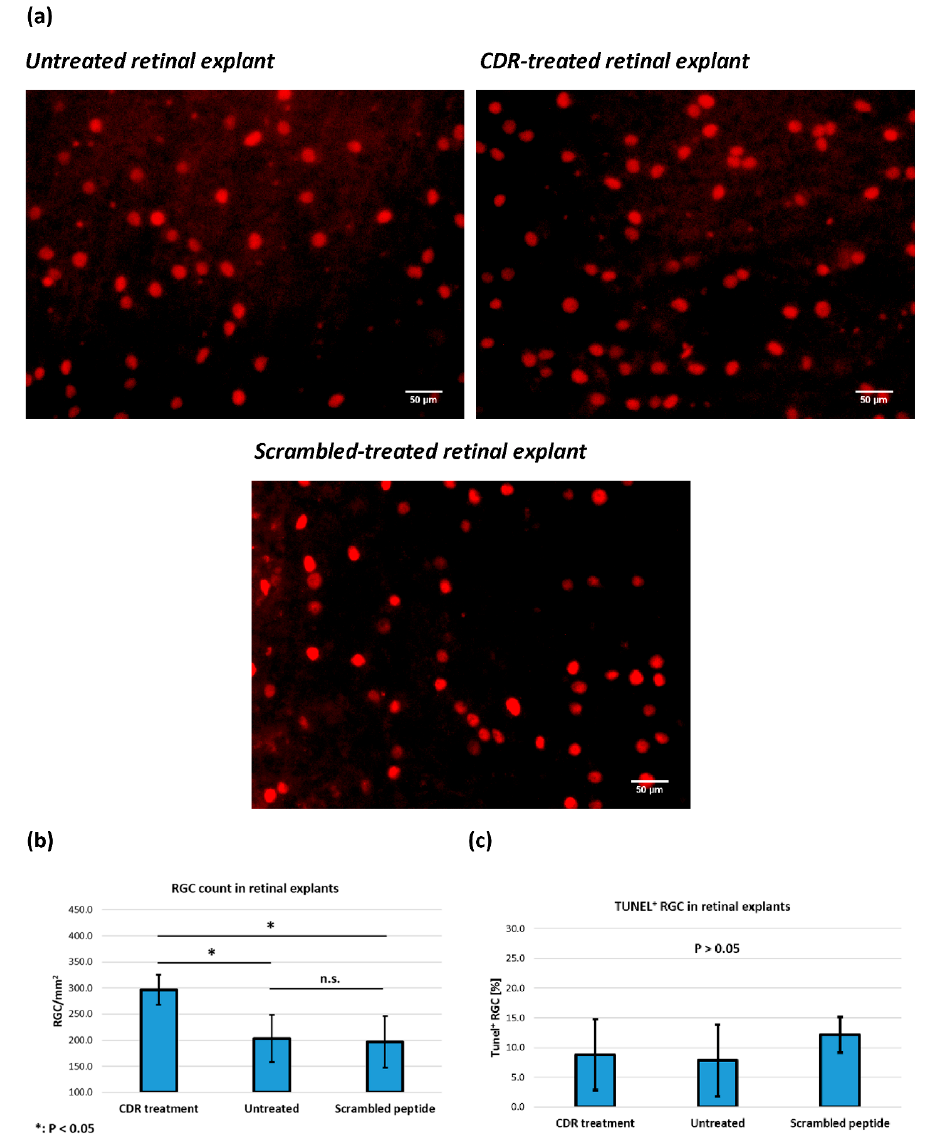
± 45 RGC/mm 2 , n = 4, p = 0.013).